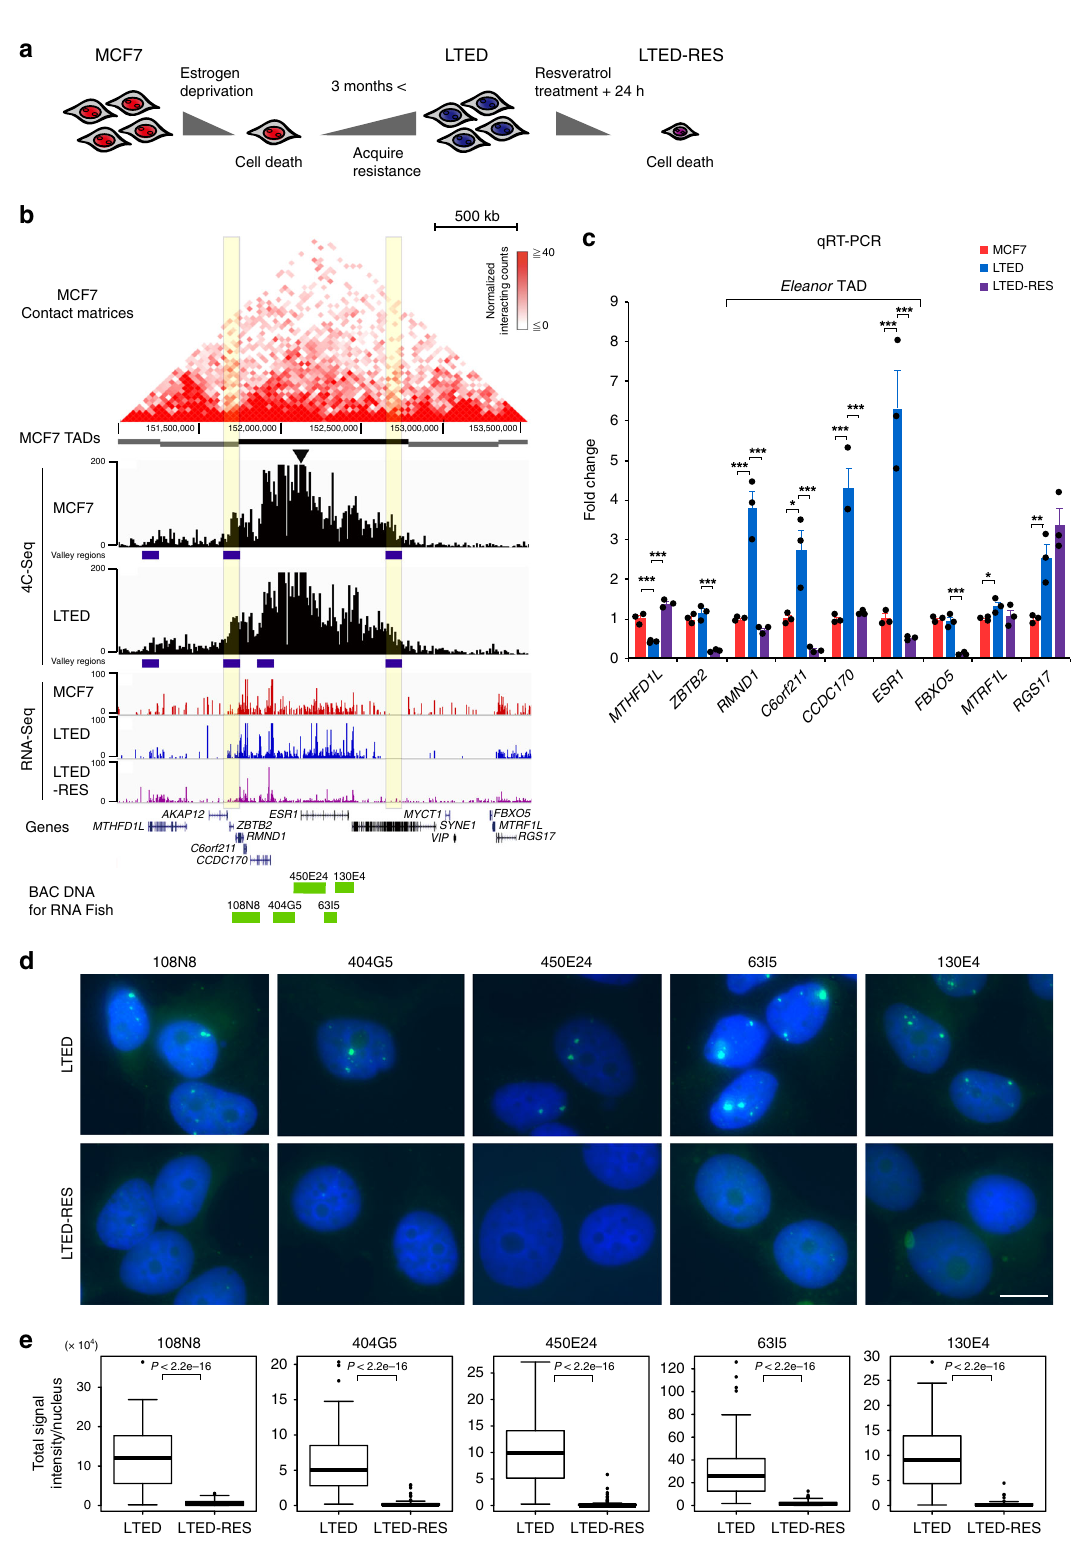
after resveratrol treatment (Fig. 1c). The same TAD-based gene regulation was observed in another ER-positive breast cancer cell line HCC1428 as well as in LTED cells (HCC1428-LTED) and resveratrol-treated cells (HCC1428-LTED-RES) created from the cell line ( Supplementary Fig. 2d). Our RNA-Seq of MCF7, LTED, and LTED-RES cell data also support the theory that the four clustered genes are co-regulated in the Eleanor TAD